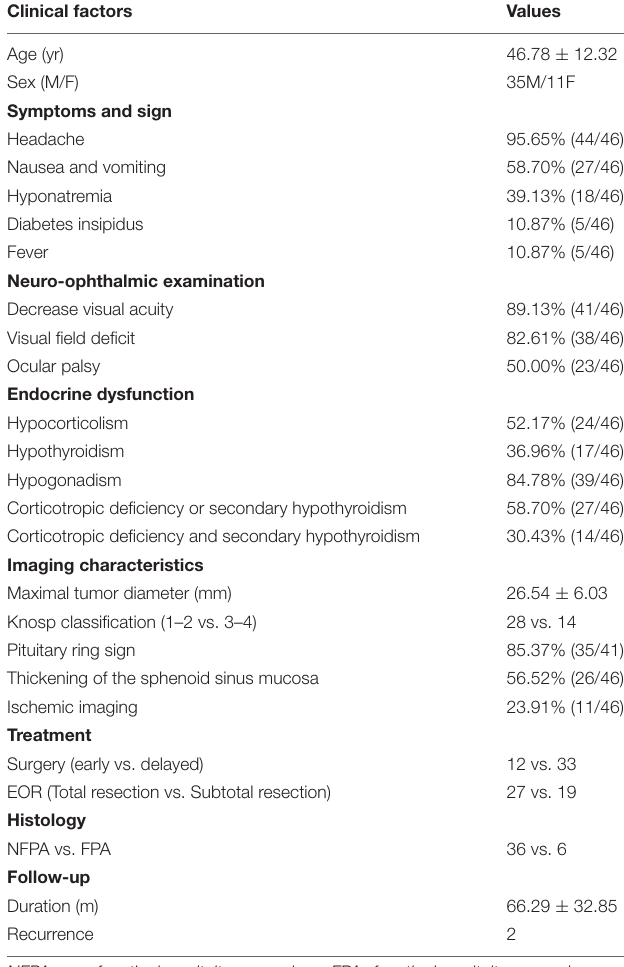
TABLE 1 | Baseline characteristics of among 46 patients with ischemic